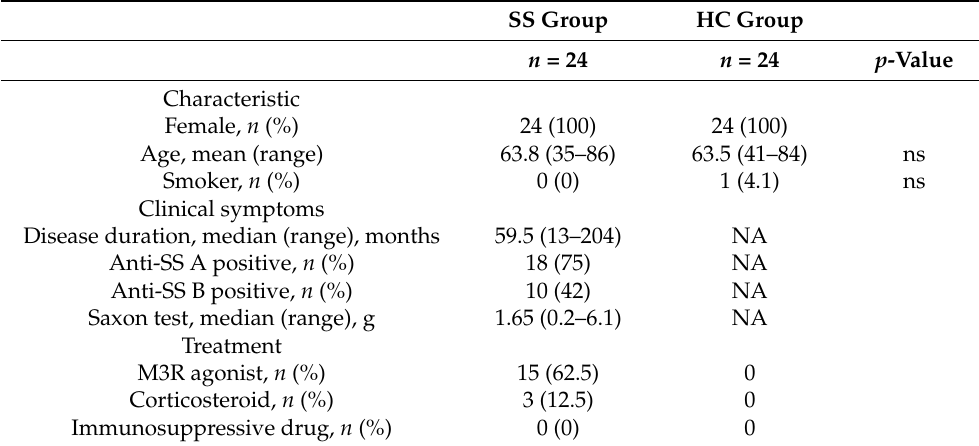
Table 1. Clinical characteristics of study